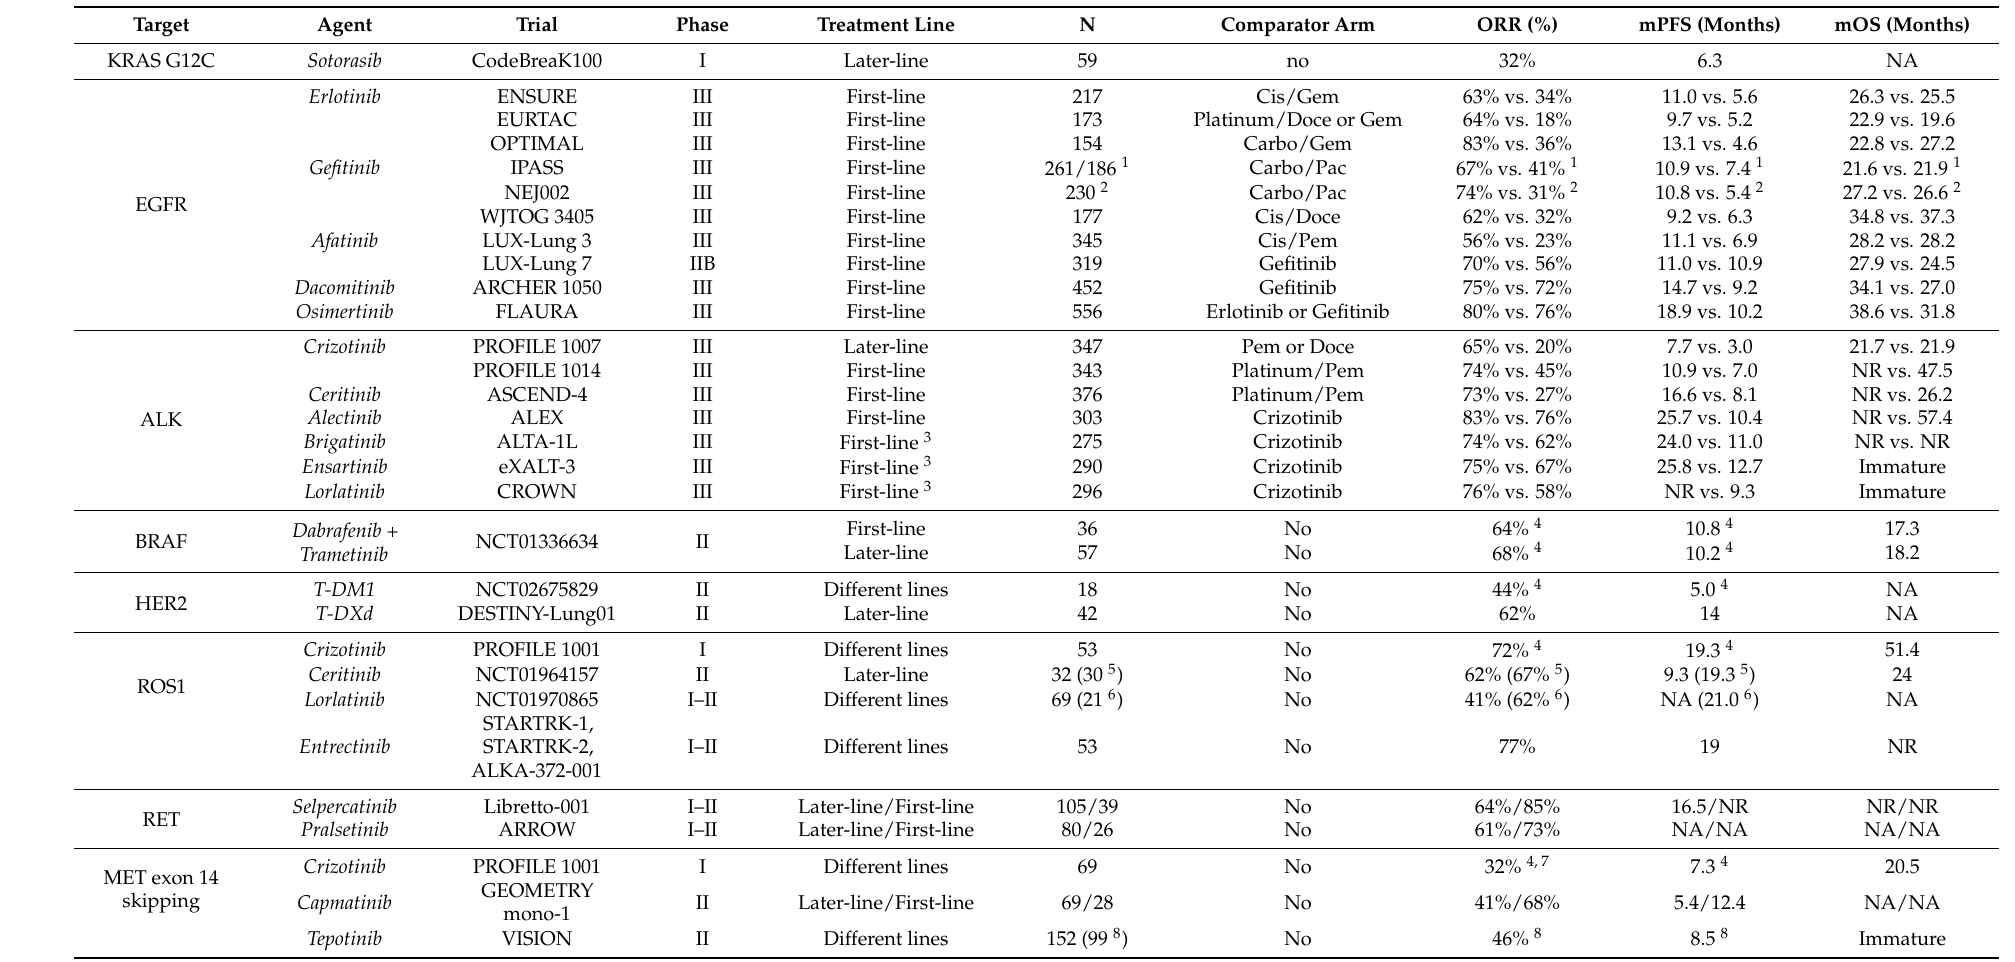
Table 2. Selected clinical trials of targeted